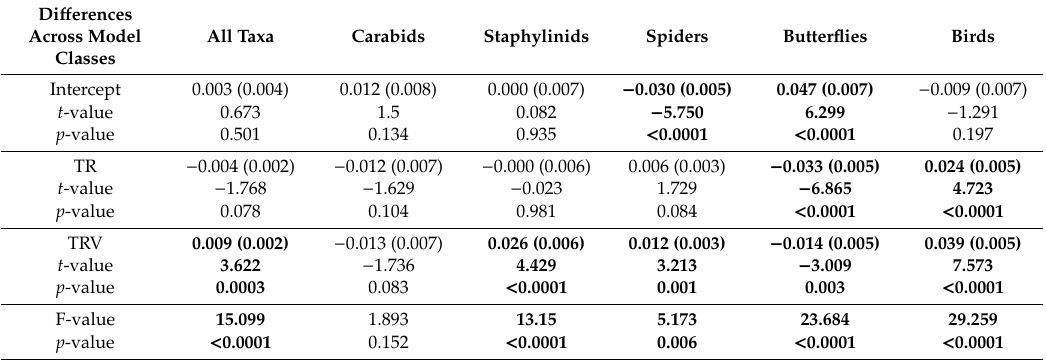
Table 2. Di ff erences across model classes. Results of e ff ect size analysis across model classes by linear mixed e ff ect models, for all taxa pooled together and for each taxon separately (DF = 494, plot identity as a random e ff ect). The baseline is the T model. The estimates (and the standard errors) of the fixed e ff ects are reported, followed by t -values and p -values. The ANOVA test of the global e ff ect of the factor variable “model class” is reported in the lower two rows (F-value and p -value). Significant values are indicated in